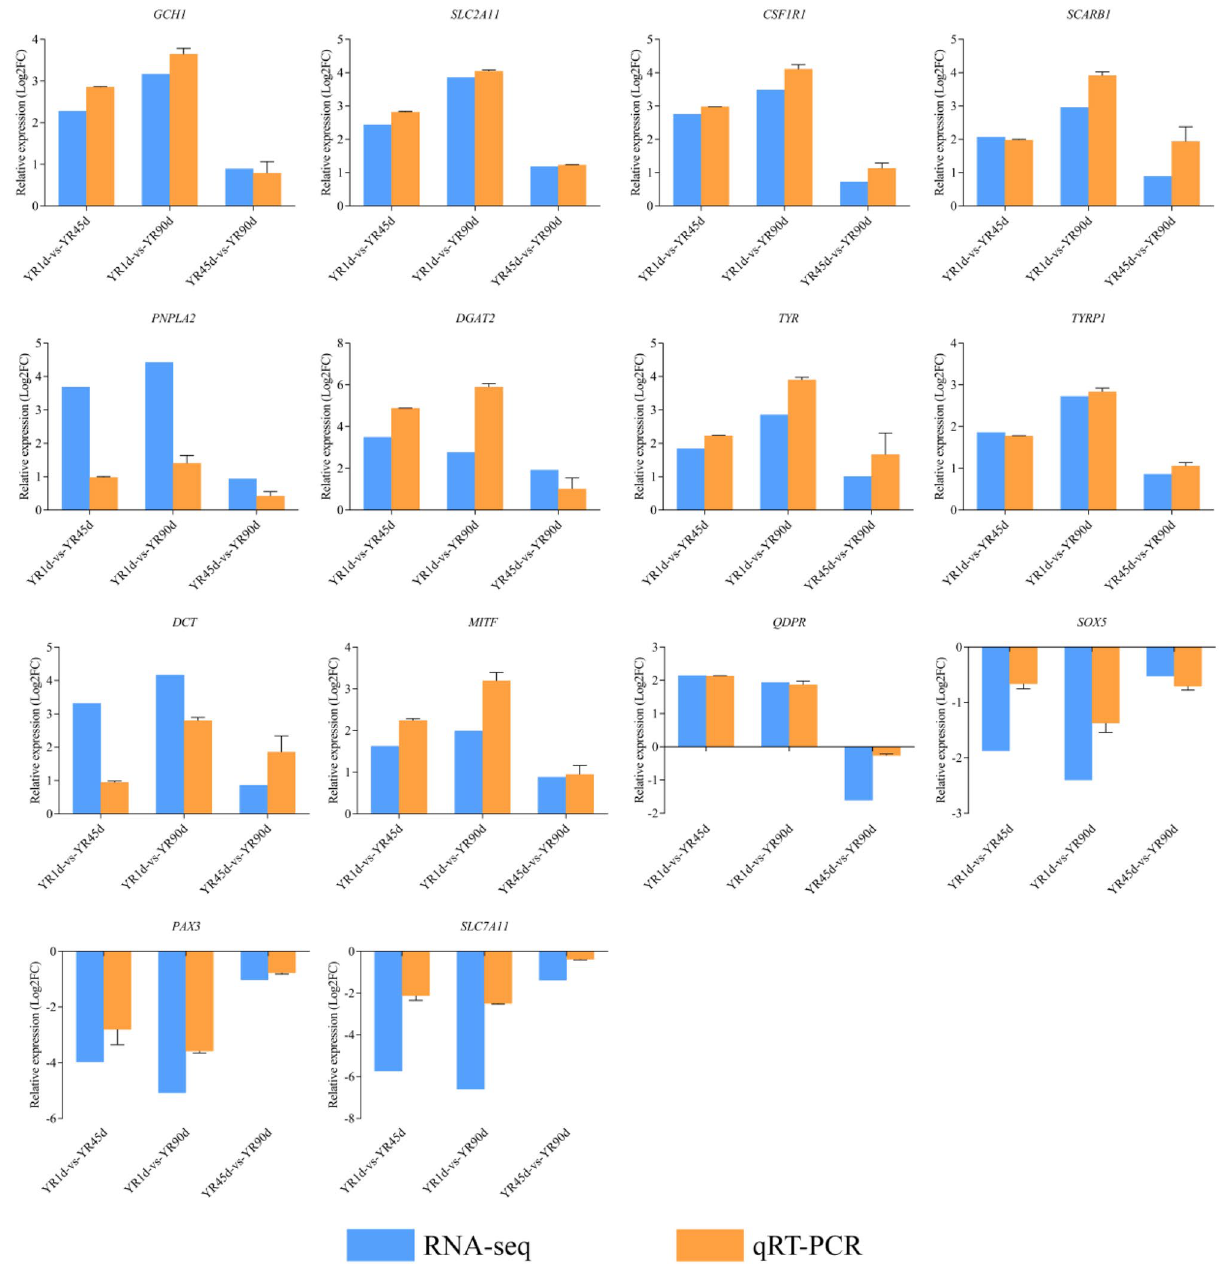
Figure 11. Validation of DEGs by qRT-PCR. The green columns indicate the results of RNA-seq and the red columns represent the results of qRT-PCR. Log2FC refers to the log2 fold